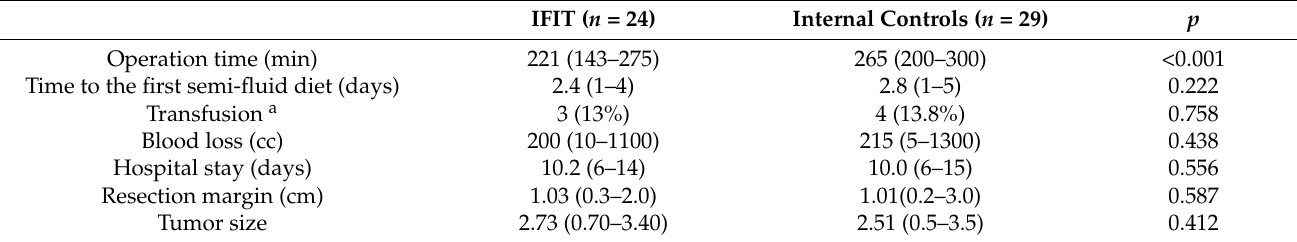
Table 2. Comparison of the clinicopathologic outcomes between the study group and internal